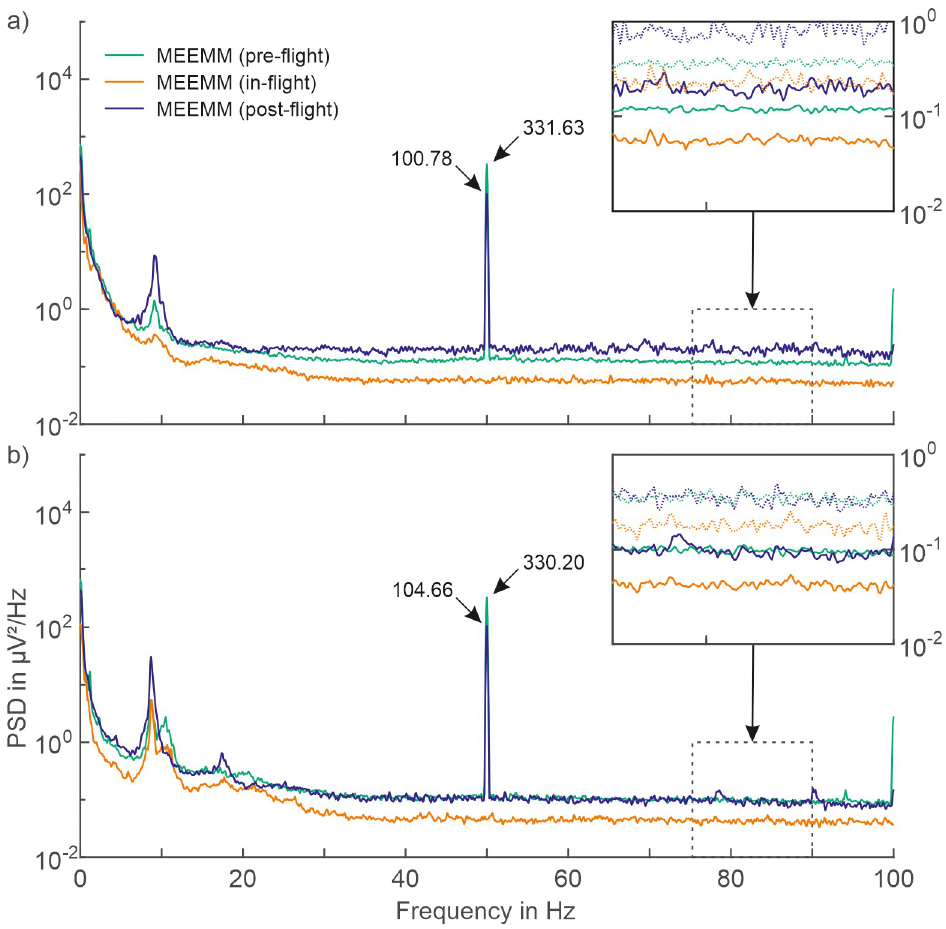
Fig 2. Comparison of power spectral density (PSD) between in-flight and ground-level EEG recordings. Average PSDs of 30 seconds of resting-state EEG data recorded with the MEEMM system during ground-level (pre- and post- flight) and in-flight conditions with a) open eyes, and b) closed eyes of the participants. Solid lines represent mean; dotted lines represent mean + standard deviation.